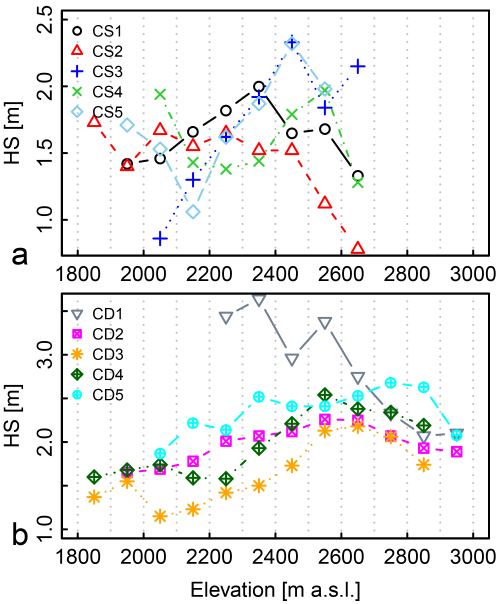
Figure 6. Elevation gradients of selected sub-catchments from the Strela mountain range (a) and the Dischma valley (b) .